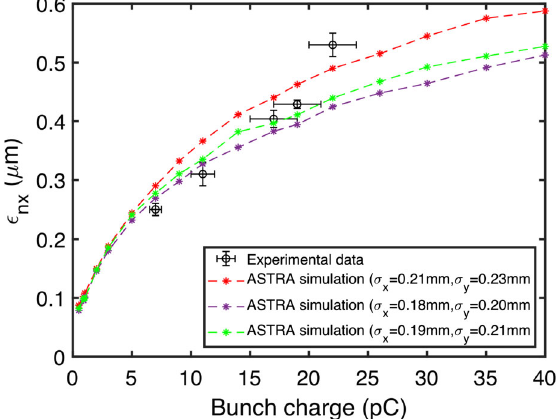
FIG. 9. Total normalized beam emittance as function of bunch charge for Y thin film on Cu substrate photocathode (x-plane): measurements (black dots) and ASTRA simulations at different laser spot size (dashed line).